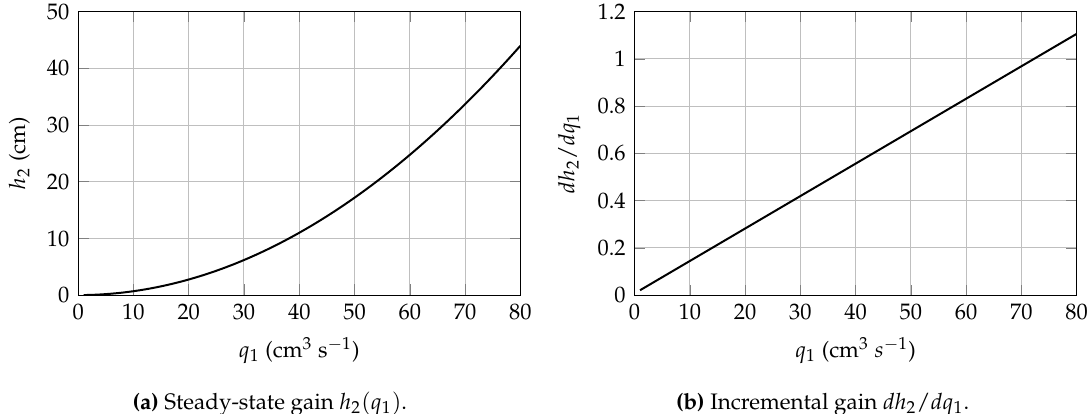
Figure 3. Steady-state gain and incremental gain variation in the Coupled Tanks Liquid Level Control problem.